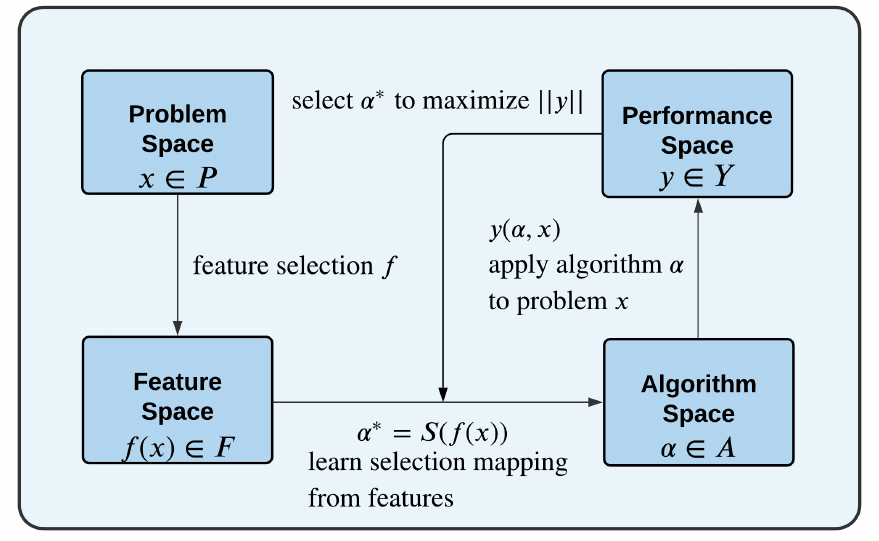
Figure 1. Rice’s algorithm selection